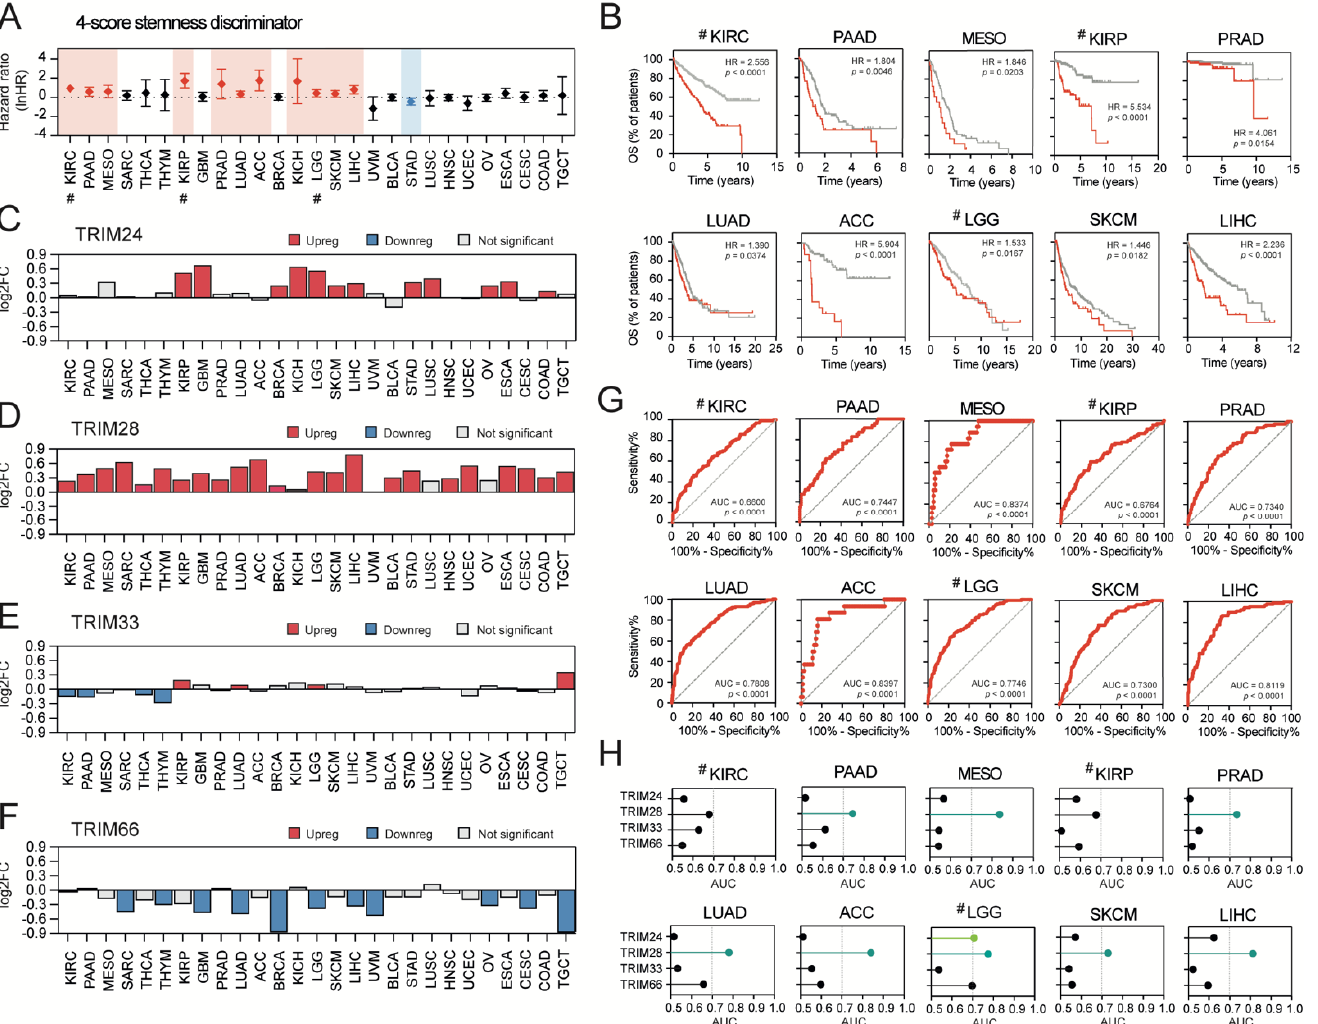
Figure 6. Stemness high tumors are associated with a worse prognosis, and TRIM28 high expression may predict stemness high phenotype. ( A ) The hazard ratio (lnHR) of death of 4 ‐ score stemness HIGH patients across 27 TCGA tumor types (# ‐ for KIRC, KIRP and LGG, the 3 ‐ score classifier was used). ( B ) Kaplan – Meier overall survival (OS) curves for 10 tumor types separated into stemness HIGH (red) or not ‐ stemness HIGH (grey) cohorts. ( C–F ) The expression of ( C ) TRIM24, ( D ) TRIM28, ( E ) TRIM33, and ( F ) TRIM66 in stemness HIGH tumors. Log2 ‐ normalized fold change (log2FC) between the stemness HIGH and other tumors is presented. ( G ) The diagnostic value of the TRIM28 expression in predicting the stemness HIGH phenotype of 10 distinct TCGA cohorts. The area under the curve (AUC) was calculated for the Receiver Operating Characteristics (ROC) curve. ( H ) Similarly, the diagnostic value for other TIF1 family members in predicting the stemness HIGH phenotype across 10 TCGA tumor types is shown. The AUCs for TRIM28 exhibit the highest values.